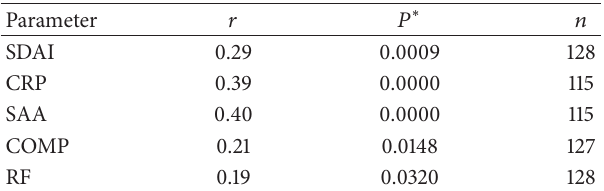
Table 2: Correlations of MMP-3 with indices of disease activity and noncytokine